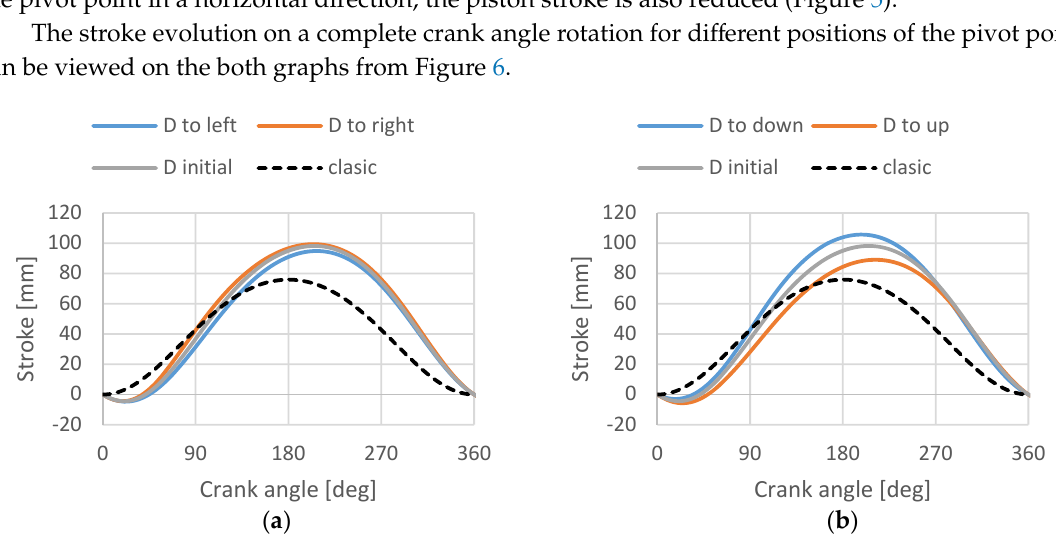
Figure 6. Piston stroke evolution during complete rotation of crankshaft when the pivot point is moved in: ( a ) horizontal direction ( b ) vertical direction.